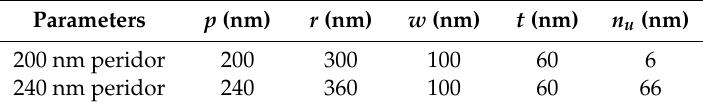
Table 1. Optimized structural parameters of the plasmonic lens.